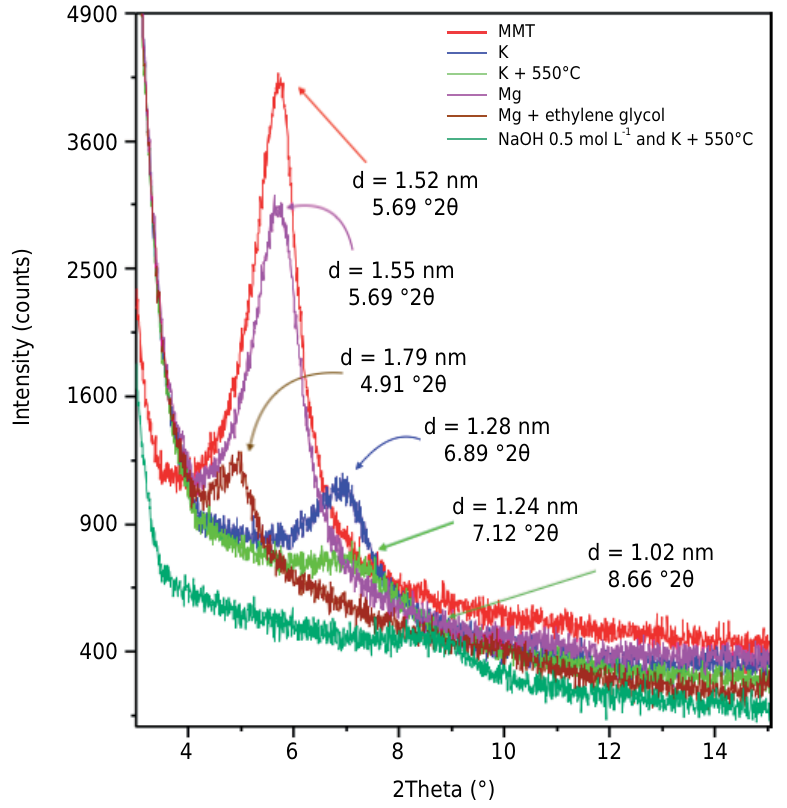
Figure 4. XRD of the sample submitted to the treatments with Mg 2+ , Mg 2+ ethylene glycol, K + , and K + + 550 °C and extraction with NaOH followed by saturation K + + heating at 550